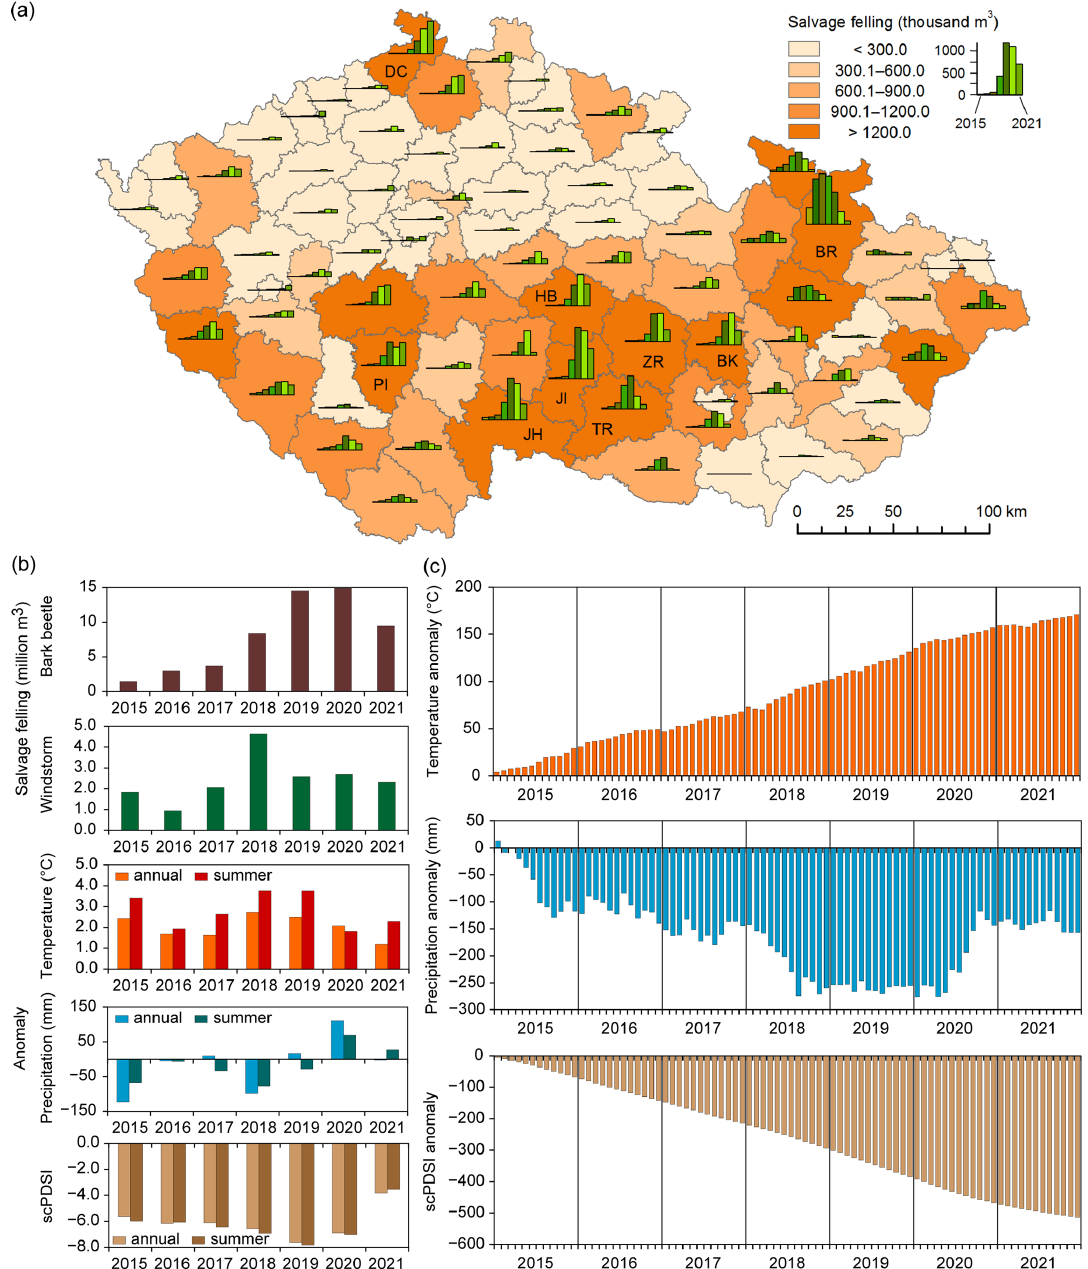
Figure 10. Bark beetle outbreak of the 2010s–2020s on the territory of the Czech Republic: (a) the volume of bark beetle salvage felling in 2015–2021 in individual districts; (b) annual bark beetle and windstorm salvage felling, annual and summer anomalies of temperature, precipitation, scPDSI-12, and scPDSI-3 in 2015–2021; (c) monthly cumulative anomalies of temperature, precipitation, and scPDSI in 2015–2021 (1961–1990 reference period). Abbreviations of districts: BK – Blansko; BR – Bruntál; DC – D ˇ e ˇ cín; HB – Havlí ˇ ck˚uv Brod;